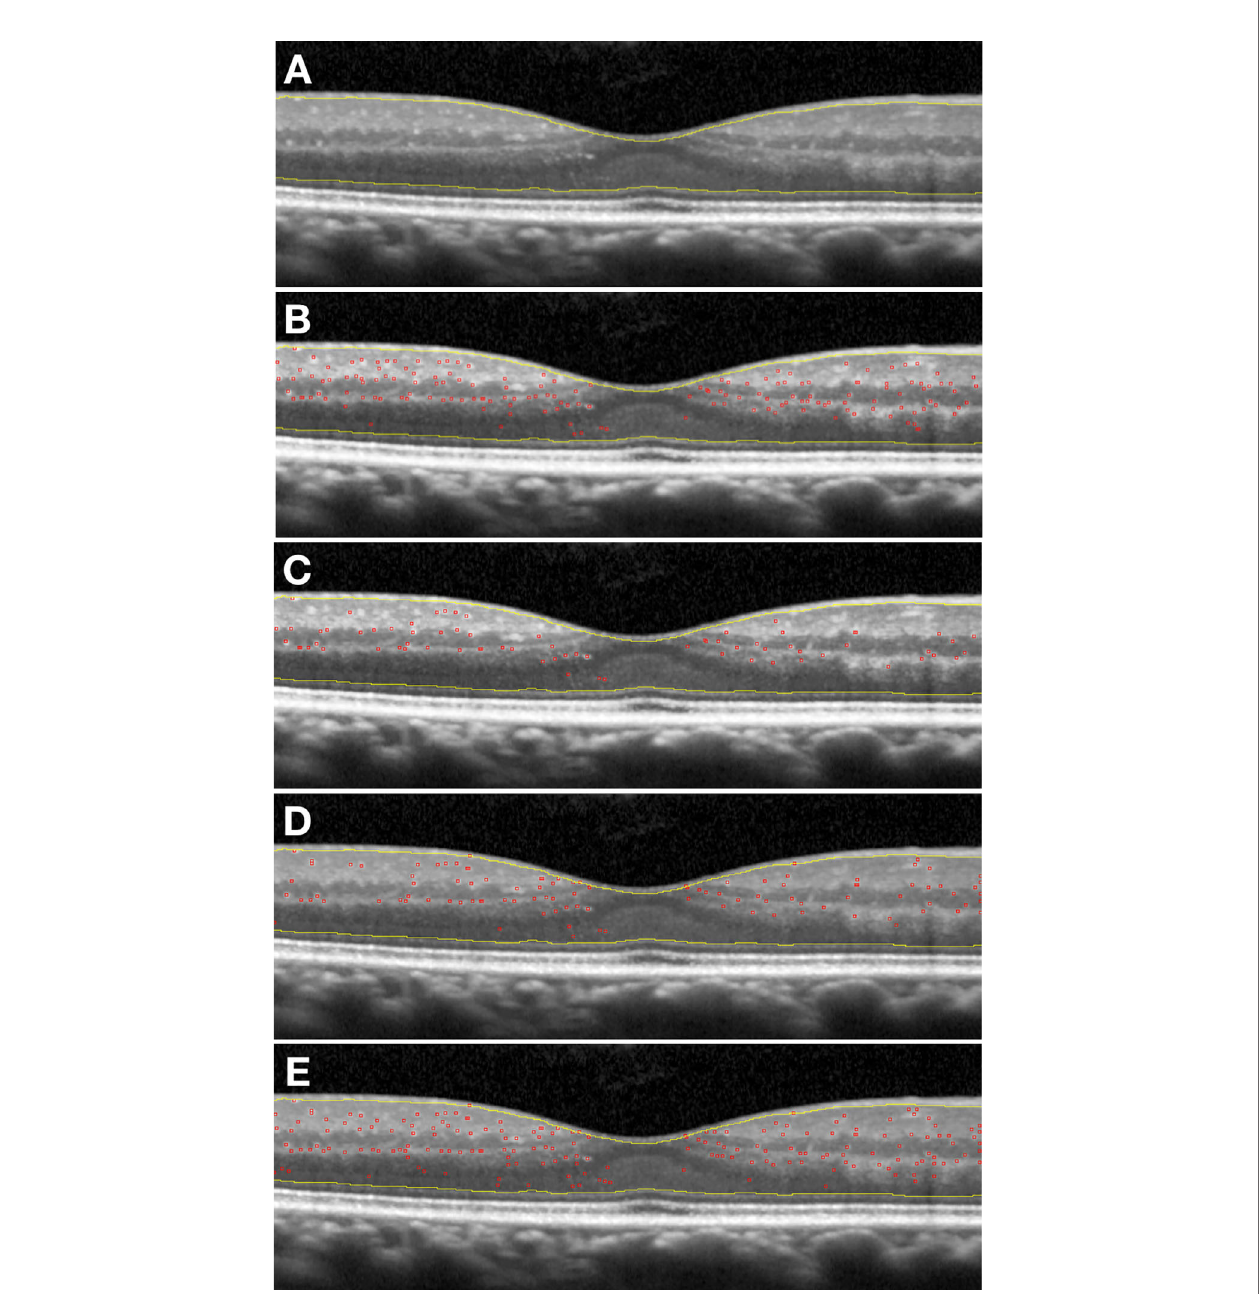
FIGURE 2 | (A) Original scan cropped, with region of interest free-hand selected; (B) Example of application First semi-automatic method; (C) Example of application Second semi-automatic method; (D) Example of application Third semi-automatic method; (E) Example of application Fourth semi-automatic